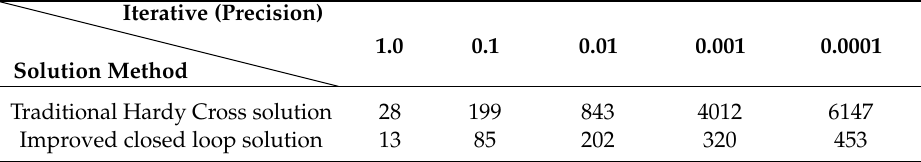
Table 4. Comparison of the iterative number for di ff erent specified iterative precisions (m 3 / s) using the traditional Hardy Cross solution method with the improved closed loop solution method.